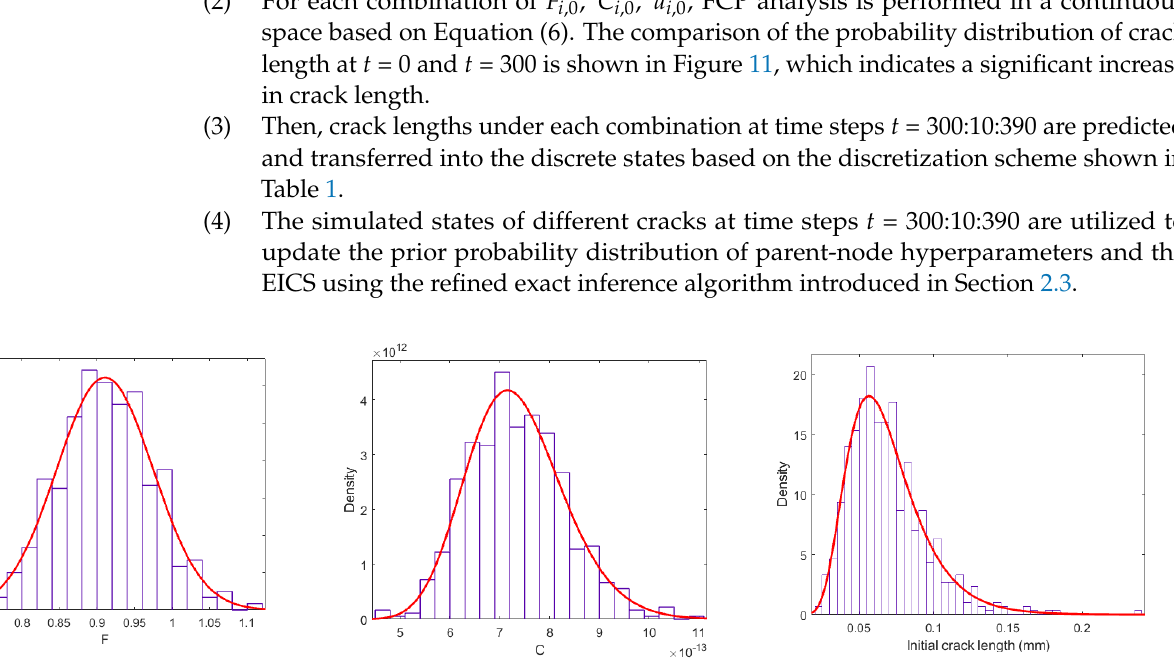
Table 4. Variable description and distribution parameters in established hierarchical DBN model.